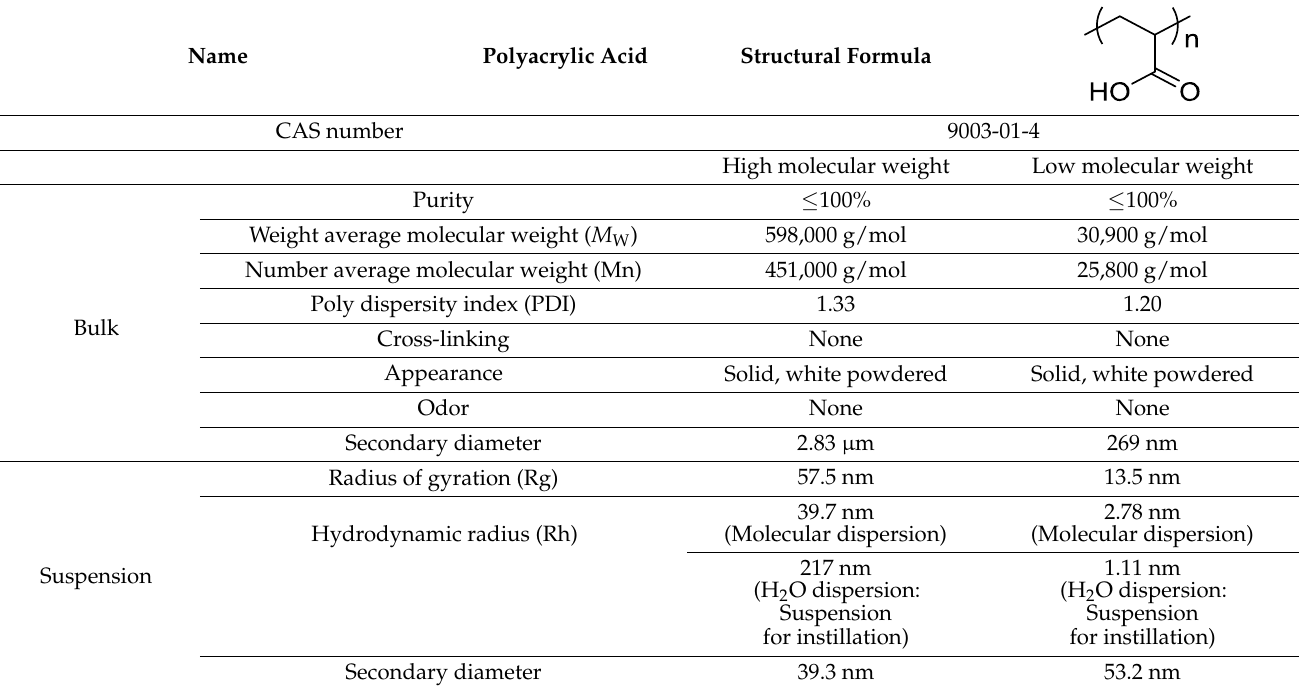
Table 1. Physiochemical characterization of the polymers used in the present study.